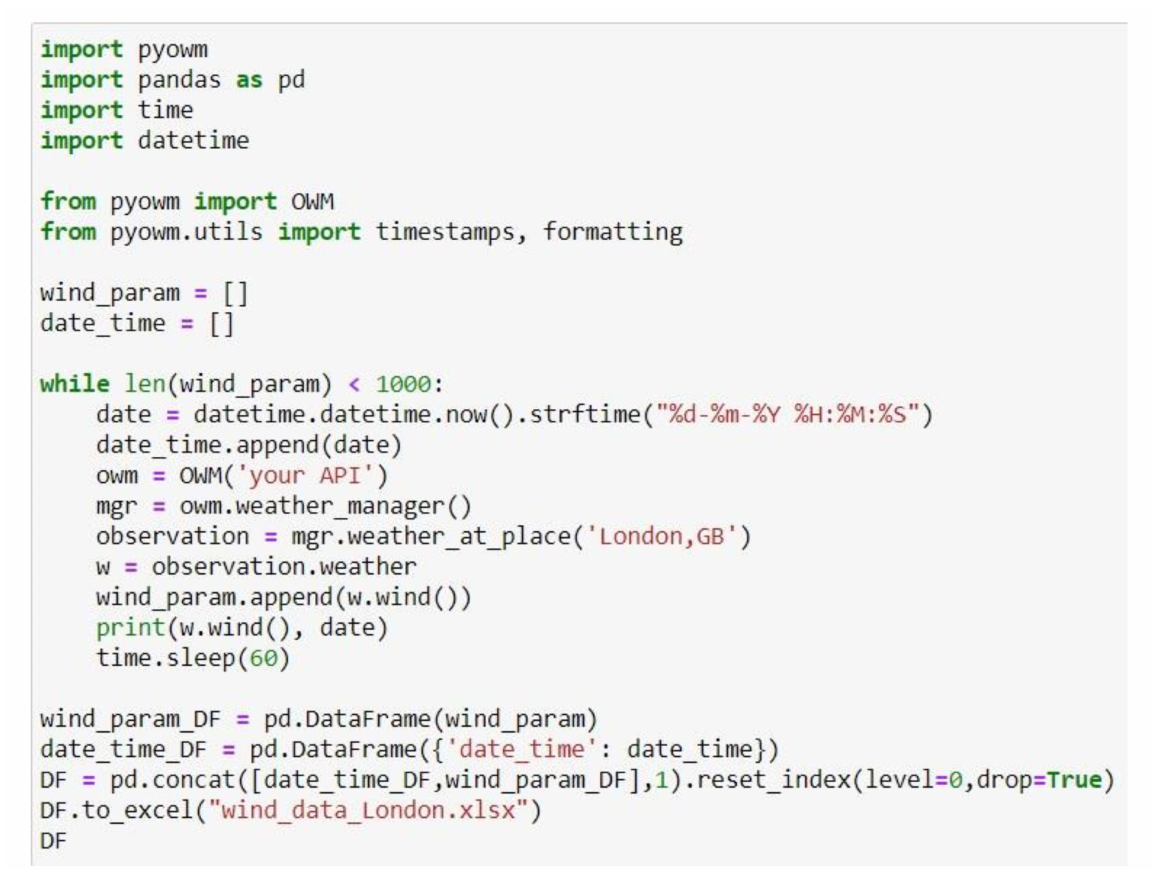
Figure 15. Code of the program for automatic collection and processing of wind speed and direction data in a given region.